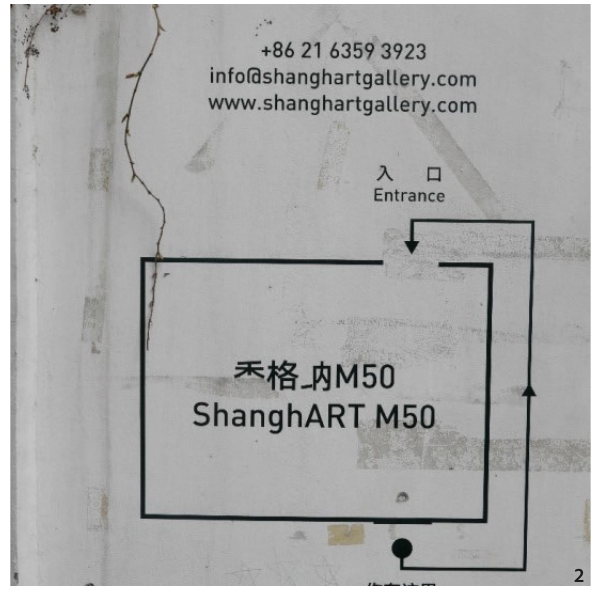
Figure 2 Tactical urbanism, when culture fit with urban renewal, M50 in Shanghai (Source: the author).